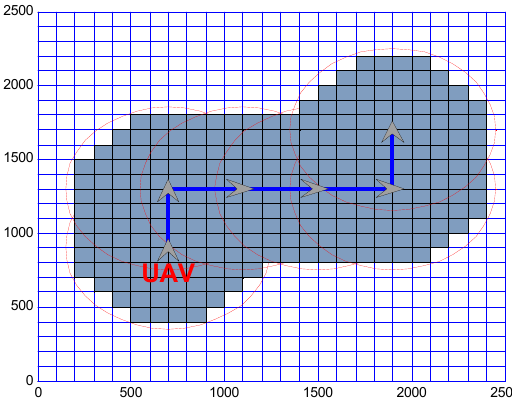
Figure 3. Schematic of coverage grids with UAV motions.